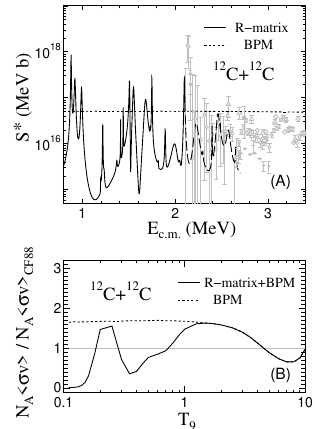
Figure 3. (A) Low-energy extrapolation of S ∗ and (B) the reaction rates. The solid and dotted curves are the results calculated from R -matrix and BPM. The experimental data are taken from [1,